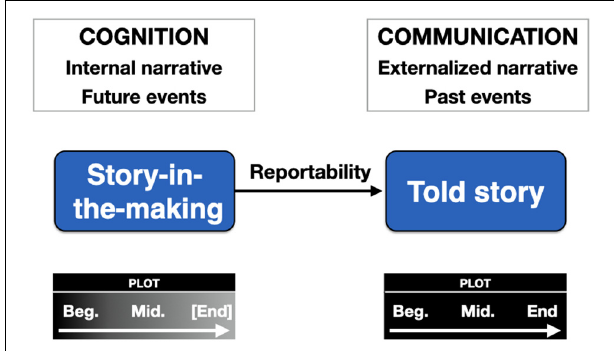
incomplete shading inside the plot box. The brackets for [End] suggest that the ending of the story has not yet occurred and can only be simulated by the person through episodic future thinking. Because cognition deals with ongoing narratives, the major focus is on future planning for goal-directed actions, hence prospection. Once such goal-directed plots are completed, they can become reportable as told stories about past events. Abbreviations: Beg, beginning; Mid,